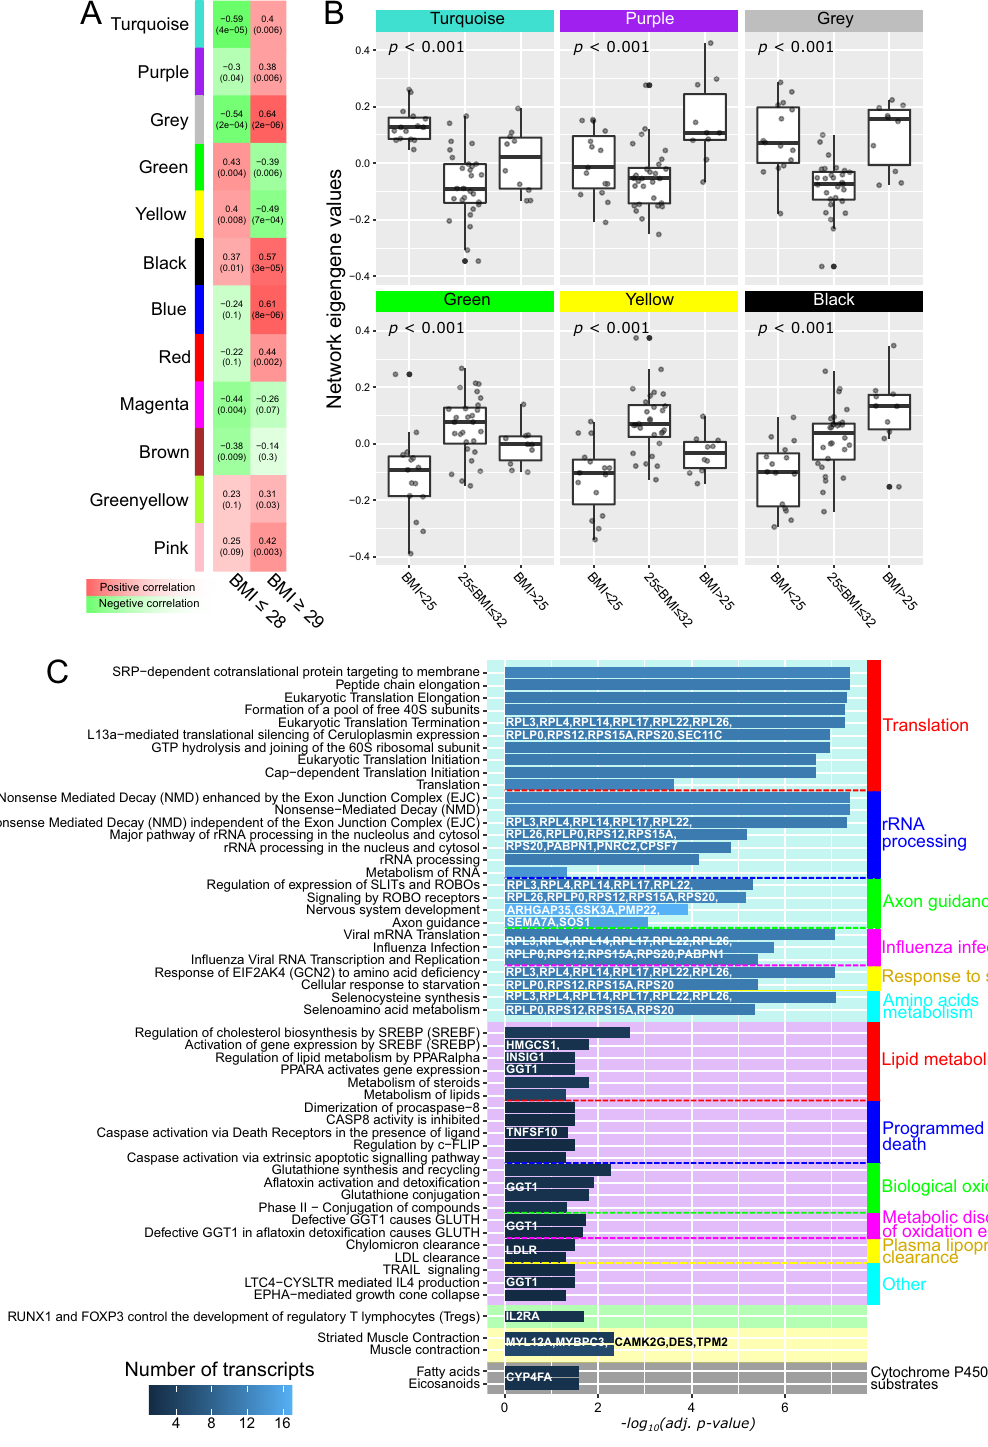
Figure 5. ( A ) Correlations between transcript networks’ eigengene values and BMI. Values is brackets are false discovery rate adjusted p values. ( B ) Boxplots of networks’ eigengene values in the BMI groups with one-way ANOVA p values. ( C ) Reactome pathway enrichments with network-specific genes. Color intensity of the bars indicate number of genes from each network that enriched particular pathways. The length of the bars indicates− log 10 ( p value). Only pathways with false discovery rate adjusted p values less than 0.05 are